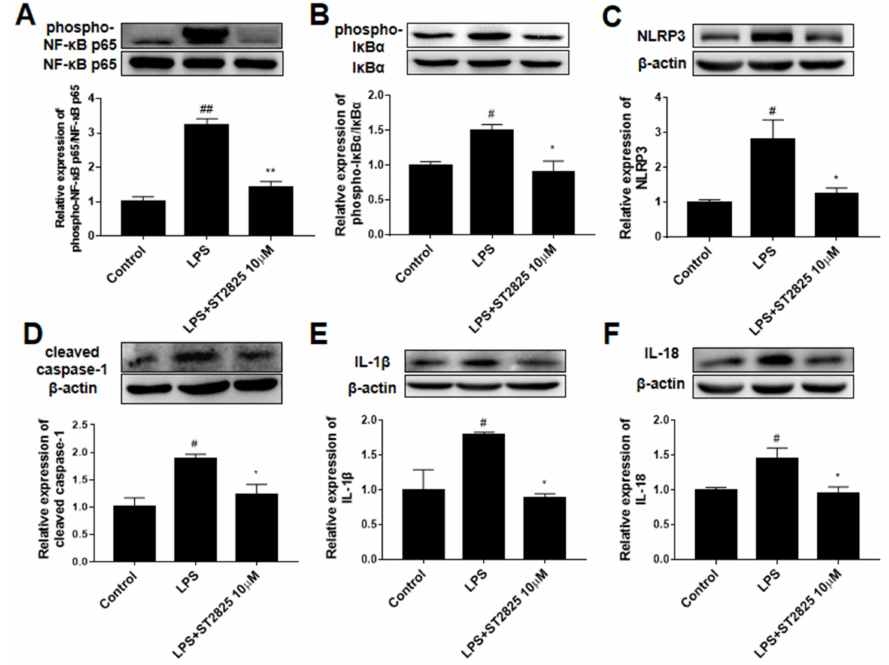
Figure 5. Effects of ST2825 on LPS-induced NF- κ B activation and the NLRP3/cleaved caspase-1 signaling pathway in BV2 cells. The protein levels of ( A ) phospho-NF- κ B p65, ( B ) phospho-I κ B α , ( C ) NLRP3, ( D ) cleaved caspase-1, ( E ) IL-1 β , ( F ) IL-18. Values are mean ± SEM ( n = 3). # p < 0.05,